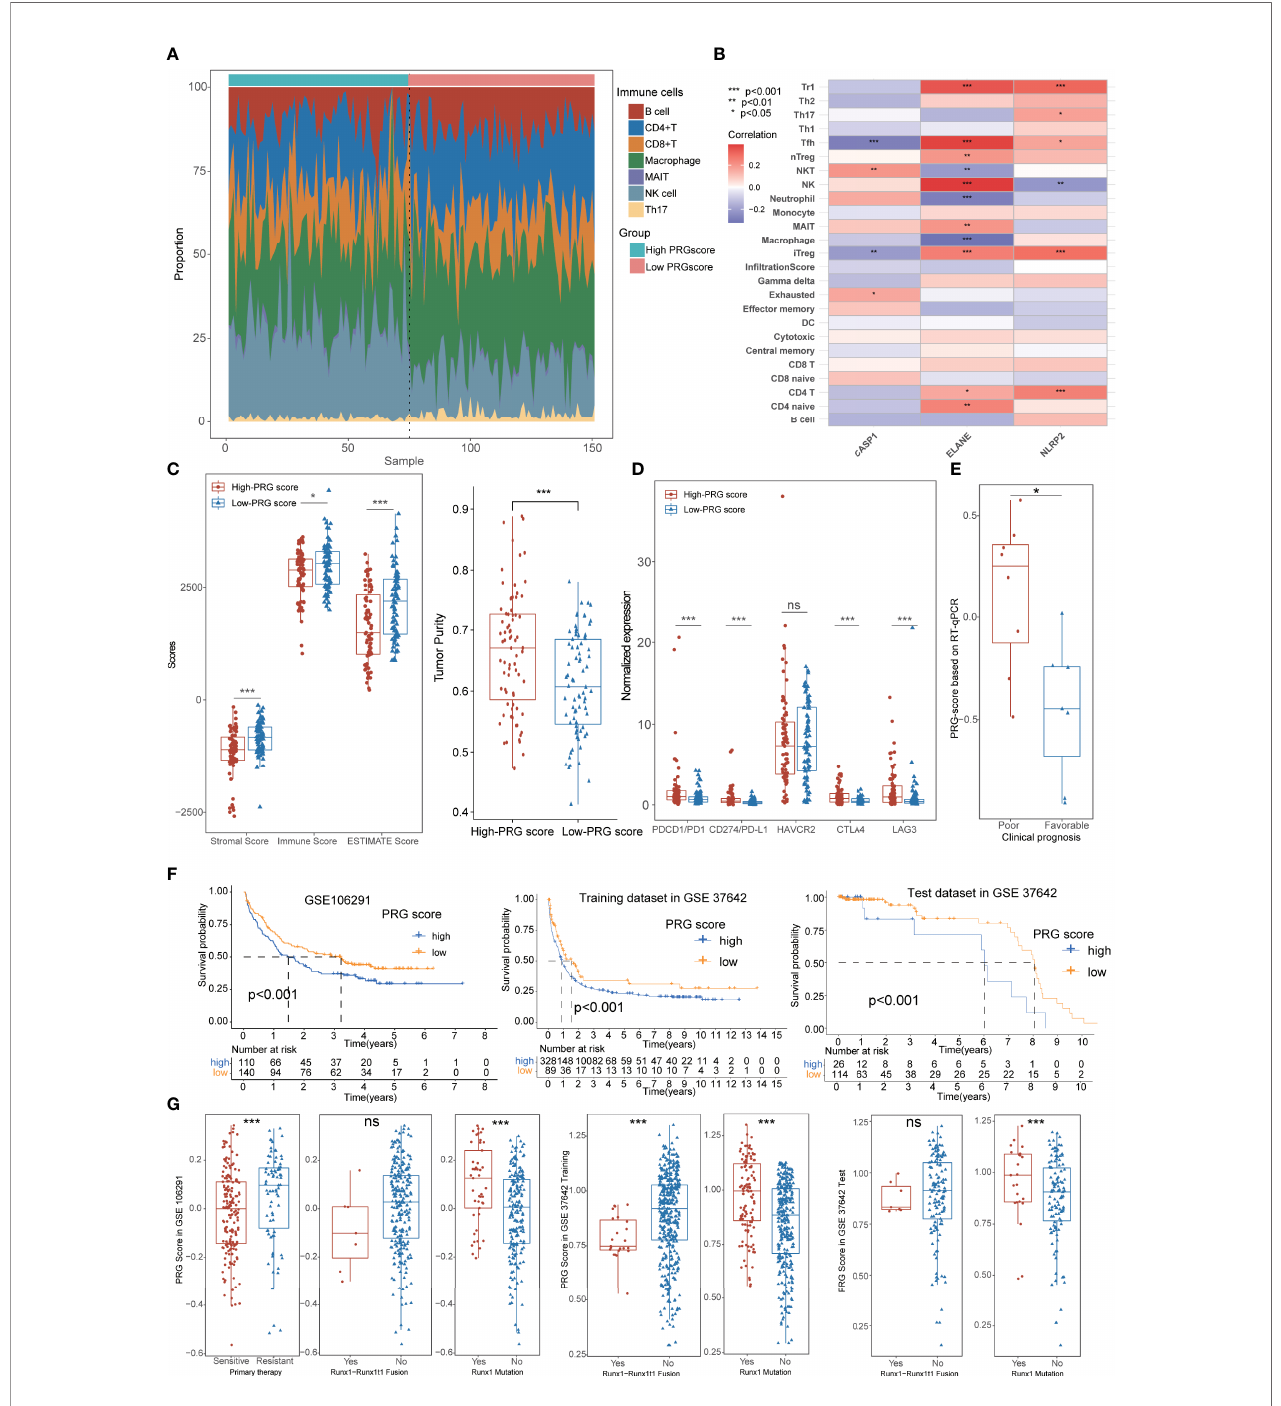
FIGURE 6 | Immunological characteristics and external validation of PRG scores. (A) The scale diagram showing the different in fi ltrate levels of immune cells between high- and low-PRG score groups. (B) Correlation analysis of immune cells and PRGs. (C) TME analysis showed that the low-PRG score patients showed higher immune and stromal scores with lower tumor purity than those of high-PRG score patients. (D) Higher expression levels of immune checkpoints were identi fi ed in high- and low-PRG score groups. (E) AML patients with favorable prognosis exhibited lower PRG scores than those of poor-prognosis patients using RT-qPCR data. (F) Survival analysis validated a better prognosis in the low-PRG score group in external datasets. (G) The boxplots showed that patients with Runx1 mutation exhibited higher PRG scores, while patients with Runx1-Runx1t1 fusion exhibited a tendency to have lower PRG scores. *P<0.05, **P<0.01, ***P<0.001; ns, not signi fi